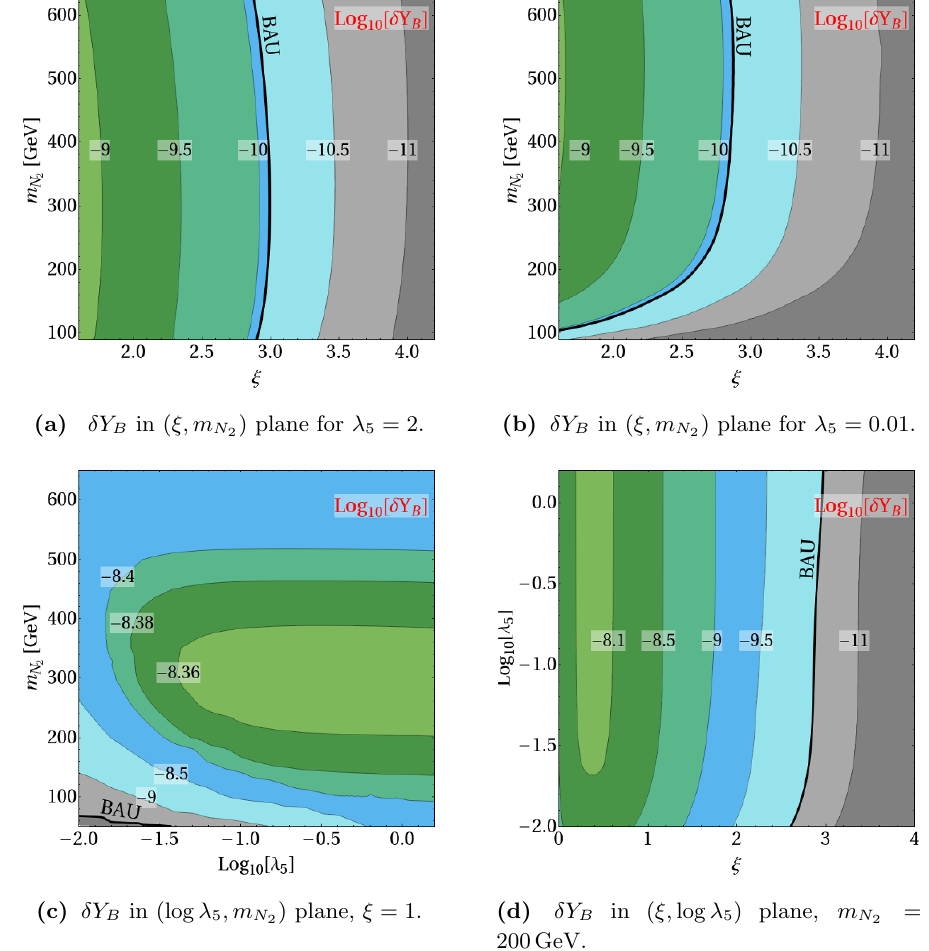
Figure 6. (cid:14)Y B shown for various choices of parameters. The level of degeneracy between N 2 and N 3 masses is (cid:12)xed to (cid:14) M = 10 (cid:0) 10 in all panels. The solid black line indicates the value of the observed baryon asymmetry of the